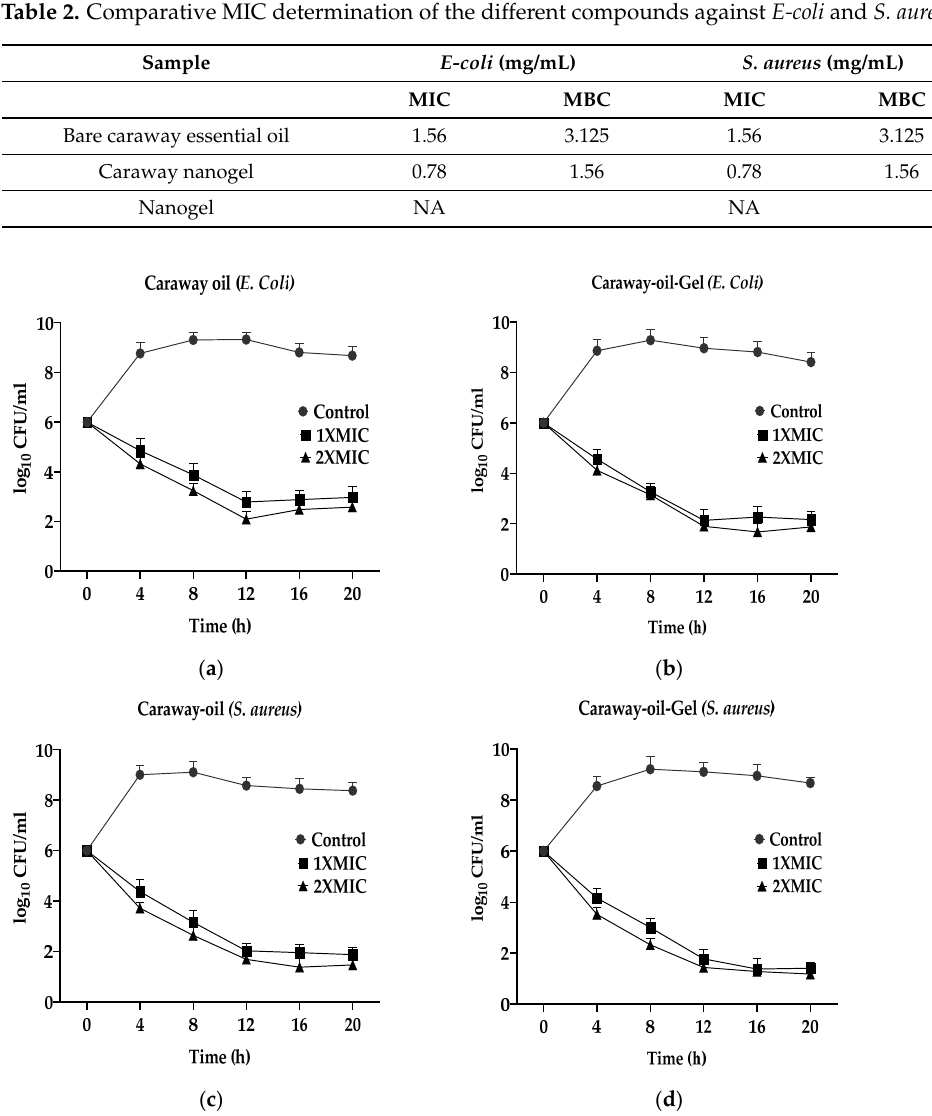
Figure 4. Time-kill assays of E. coli and S. aureus against caraway oil and caraway oil gel, where ( a ) and ( b ) are showing the effects of caraway oil and caraway oil-gel against E-coli respectively while, ( c ) and ( d ) are showing the assays of caraway oil and caraway oil-gel against S. aureus respectively .